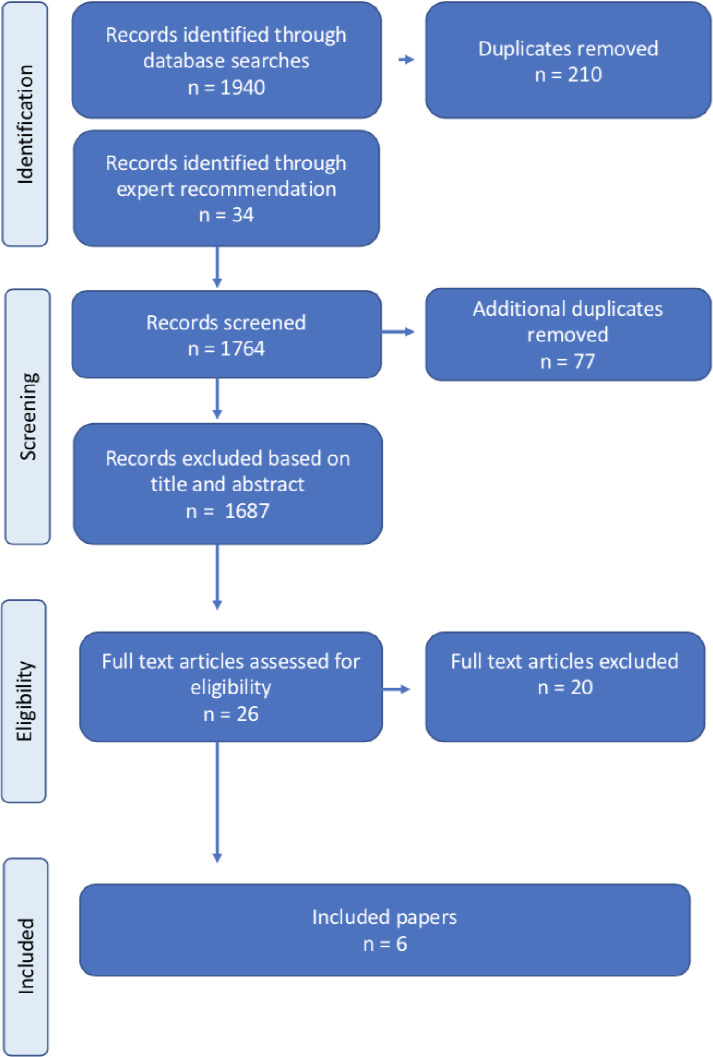
Search flowchart.